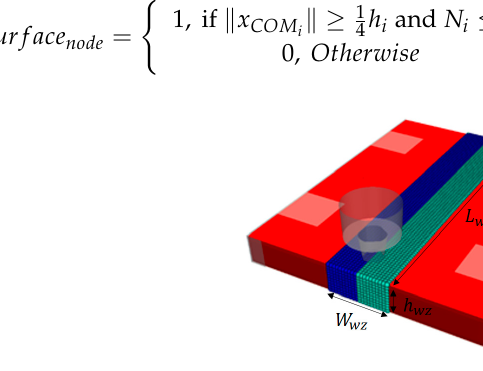
Figure 3. Measuring zone for initial pre-weld surface area.